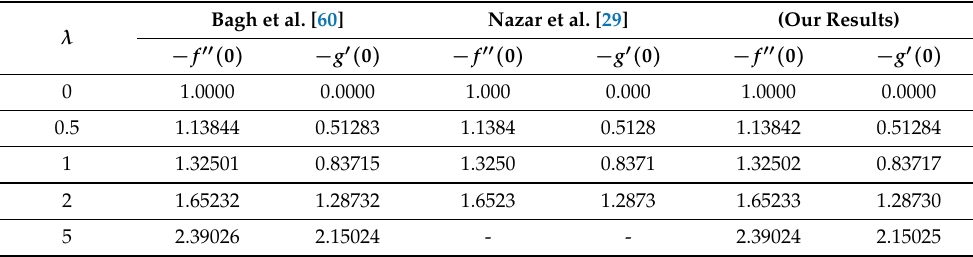
Table 3. g (cid:48) ( 0 ) and f (cid:48)(cid:48) ( 0 ) values along with distinct values of λ .